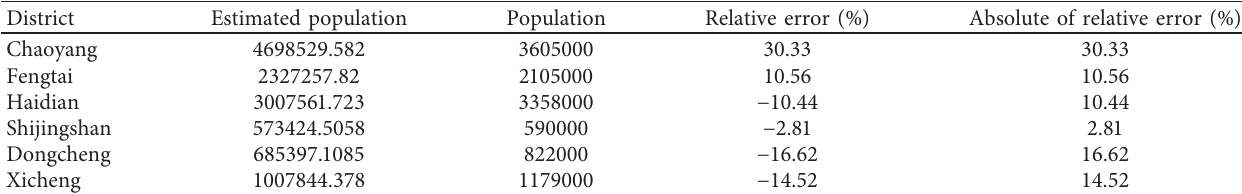
Table 2: Districts’